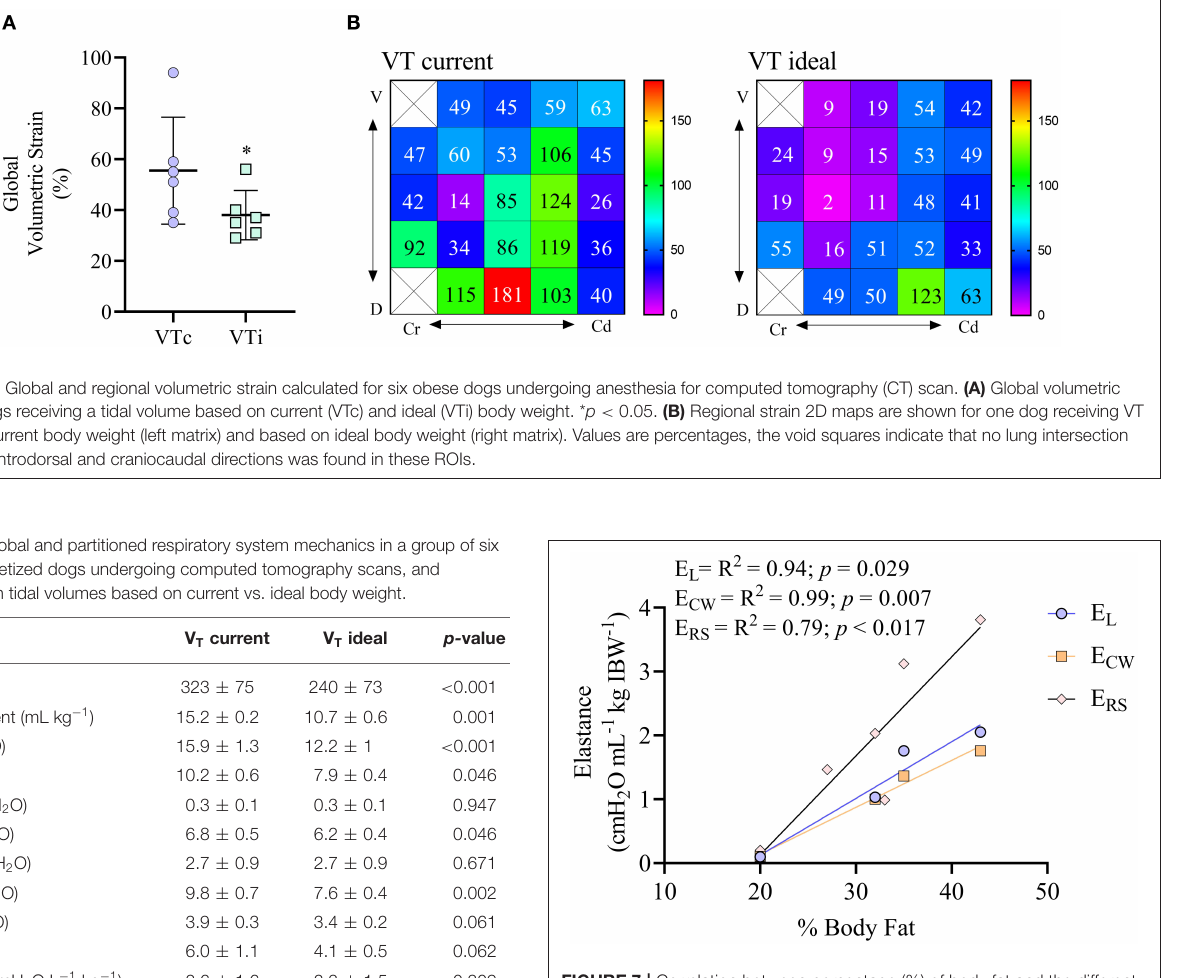
FIGURE 7 | Correlation between percentage (%) of body fat and the different elastances of the respiratory system in six obese dogs undergoing anesthesia. There are only four dogs for the elastance of the lung (E L ) and elastance of the chest wall (E CW ), since two dogs had no readings of esophageal pressure. Six dogs are shown for the correlation between the percentage of body fat and the elastance of the respiratory system (E RS